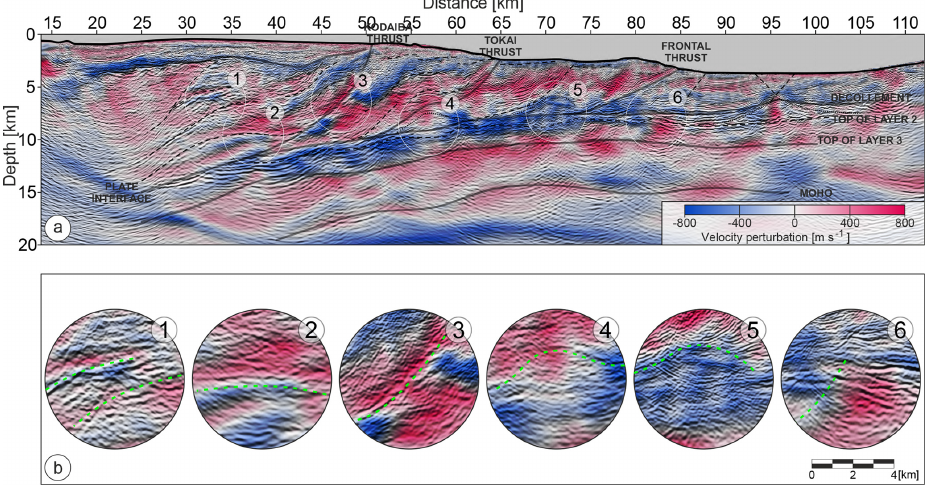
Figure 12. Imaging results and structural interpretation. (a) Migrated section superimposed on a de-trended version of the FWI velocity model, blended with the average vertical and horizontal velocity gradient. (b) Zoom panels corresponding to circles 1–6 in Fig. 12a. Green dashed lines underline the consistency between reflectivity and background velocity